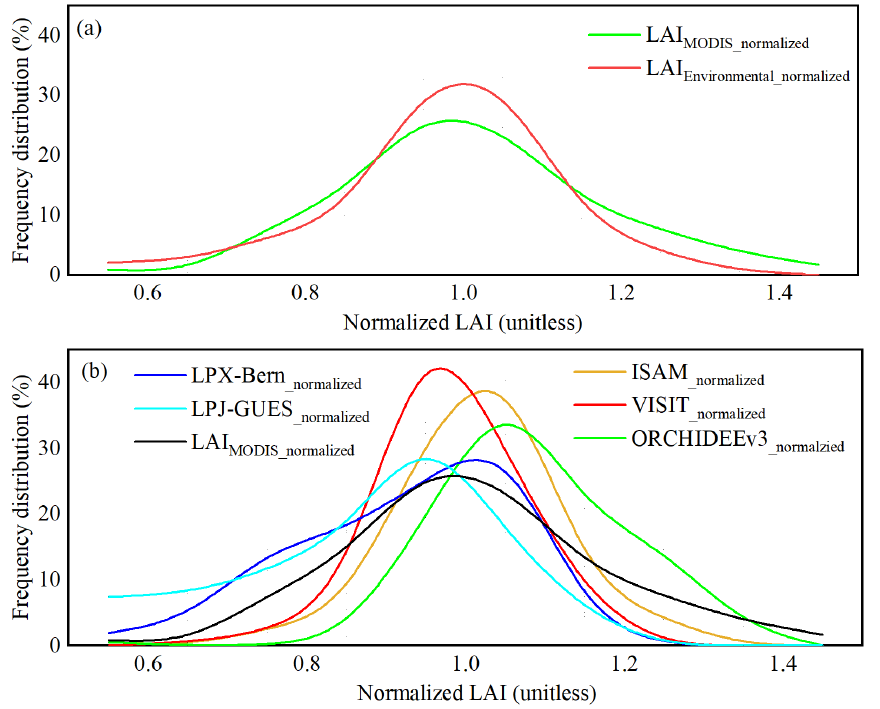
Figure 10. The frequency distribution of normalized LAI. ( a ) The frequency distribution of LAI MODIS_normalized and LAI Environmental_normalized ; ( b ) the frequency distribution of normalized MODIS LAI and normalized simulated LAI from models.